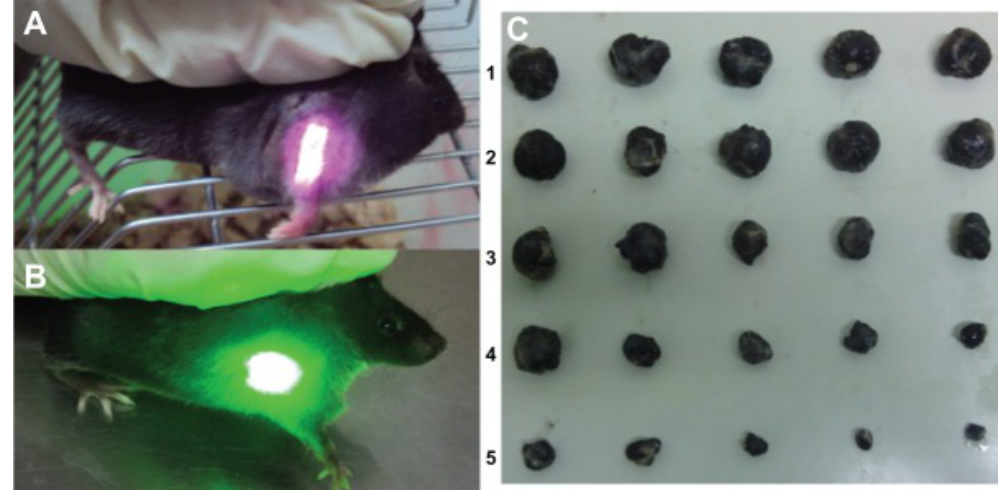
Figure 11. Tumor-bearing mice treated with: ( A ) an 808-nm near-infrared laser and ( B ) 532-nm laser; ( C ) photo of tumors taken out of the saline group (1), the HA-CNT (808 nm) laser group (2), the HMME (532 nm) laser group (3), the HMME-HA-CNT (532 nm) laser group (4) and the HMME-HA-CNT (532/808 nm) laser group after treatment for eight days (5). Reproduced from [122]. Copyright 2013 Dove Medical Press